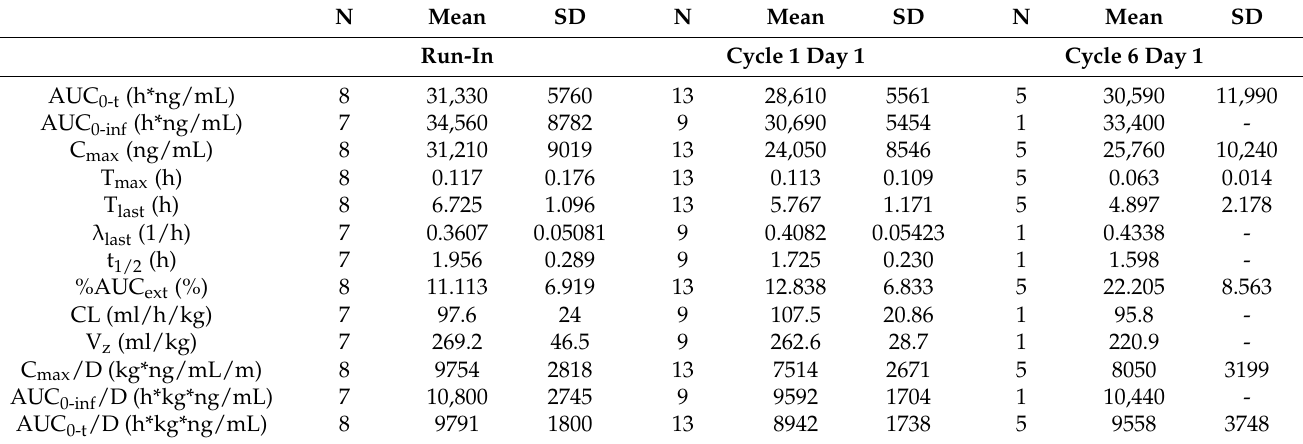
Table 2. Summary of plasma 3.2 mg/kg CEND-1 pharmacokinetic parameters in pancreatic cancer patients at run-in prior to chemotherapy treatment, cycle 1 day 1 of nab-paclitaxel+gemcitabine chemotherapy treatment, and cycle 6 day 1 of nab-paclitaxel + gemcitabine chemotherapy